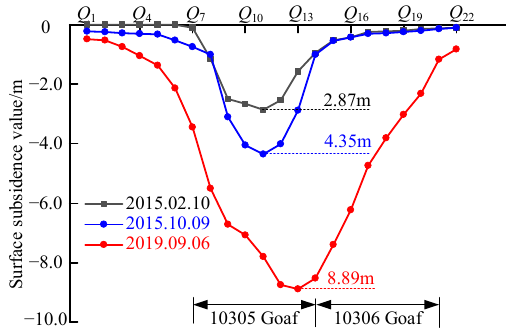
Figure 4. Surface subsidence curves of the western goaf.